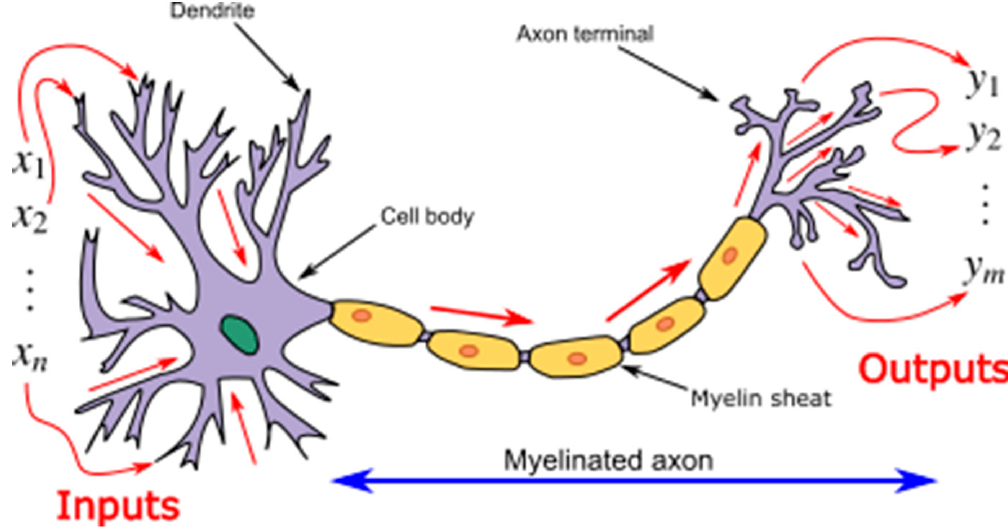
Figure 4. Signal flow diagram of the human brain [31].